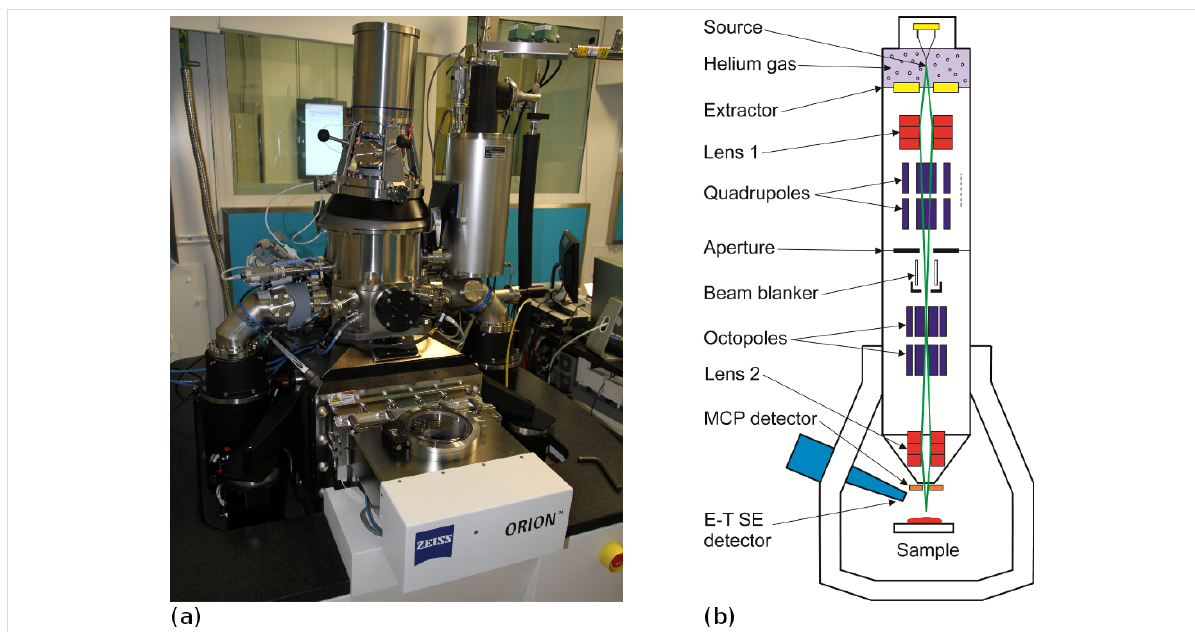
Figure 2: (a) ORION Plus He Ion Microscope from Zeiss AG, located at University of Southampton. (b) Schematic of He + ion focusing column.